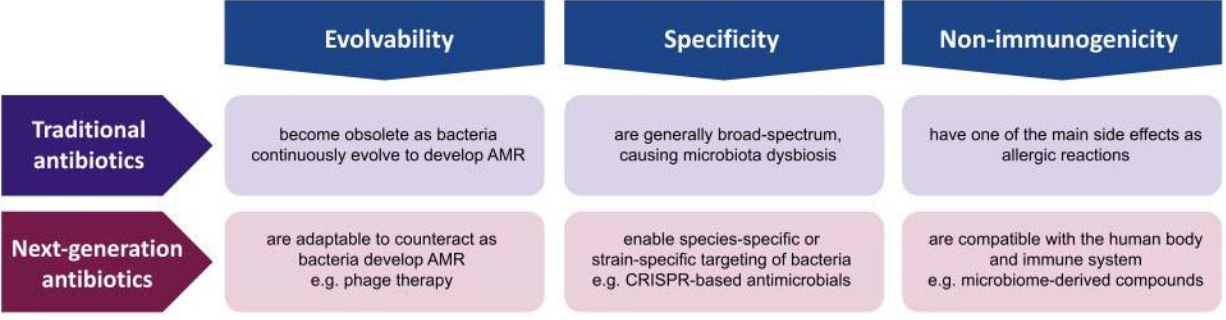
Figure 2. Traditional antibiotics versus next-generation antibiotics. Comparison in terms of evolvability, specificity, and non-immunogenicity.